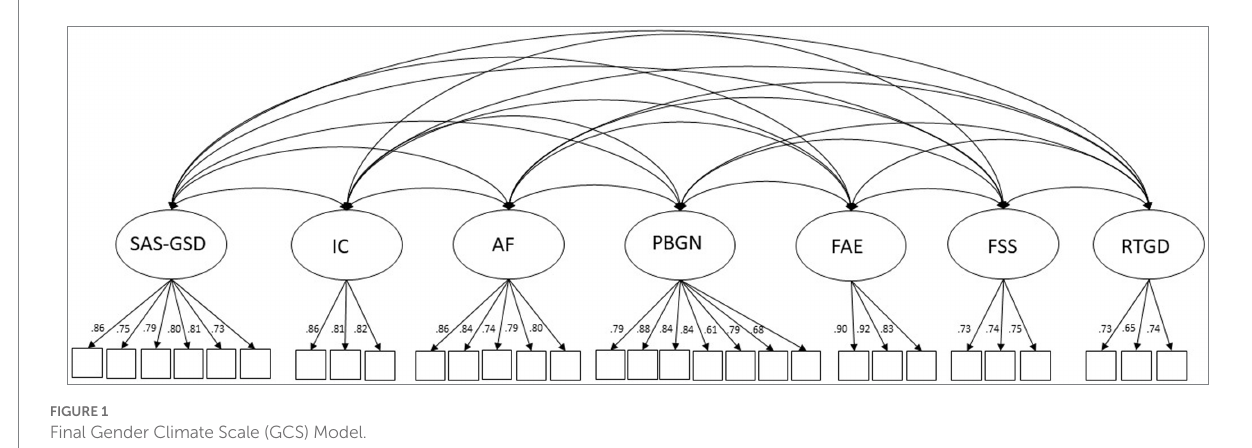
FIGURE 1 Final Gender Climate Scale (GCS)